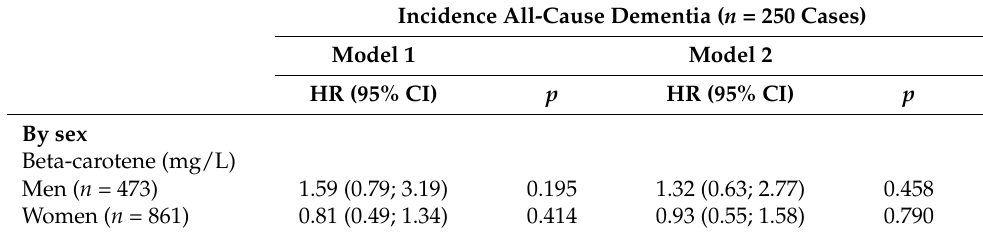
Table 4. Analyses stratified by sex ( n = 1334).